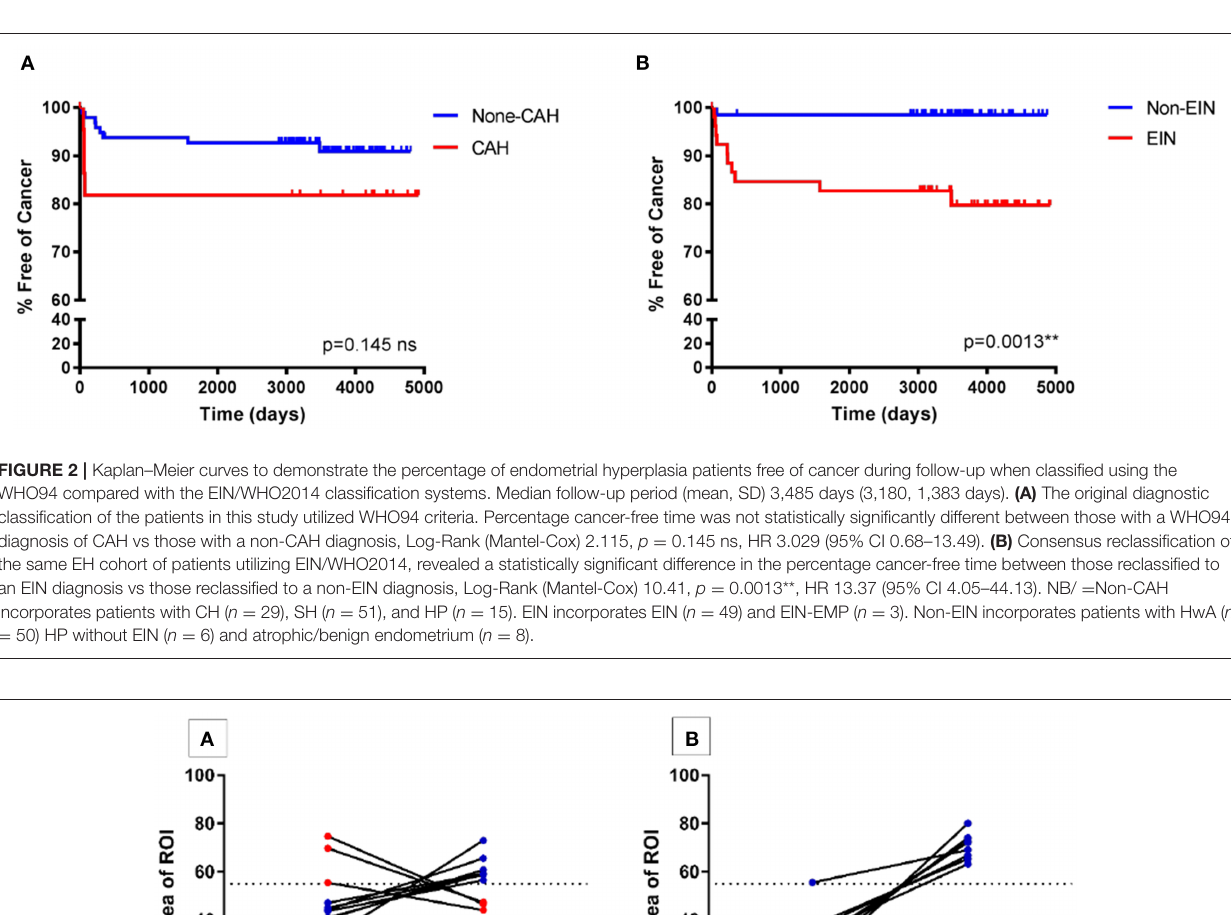
( Supplementary Table 4 , p = 0.0112, 2-sided Fisher’s exact